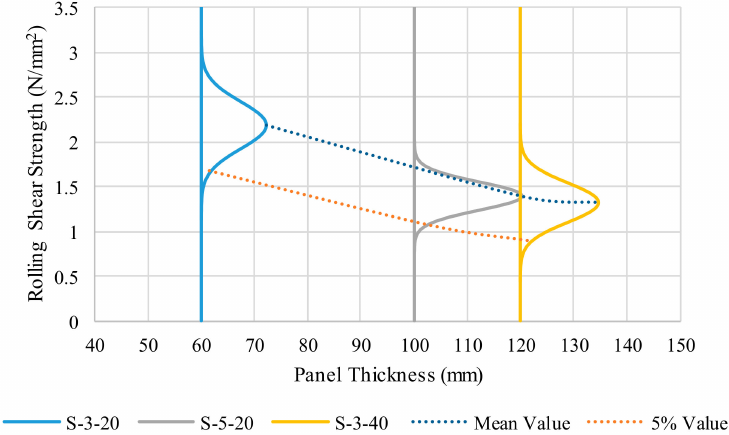
Figure 10. Rolling shear strength distribution and influence of panel thickness and number of